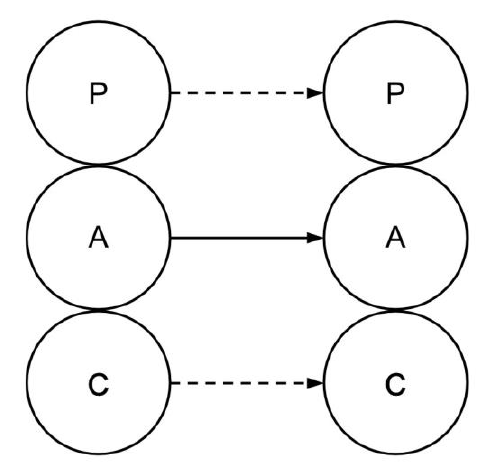
The Adapted Child-only scientist stands in the Figure 5. To grasp the full weight of the comment, each must be analysed.